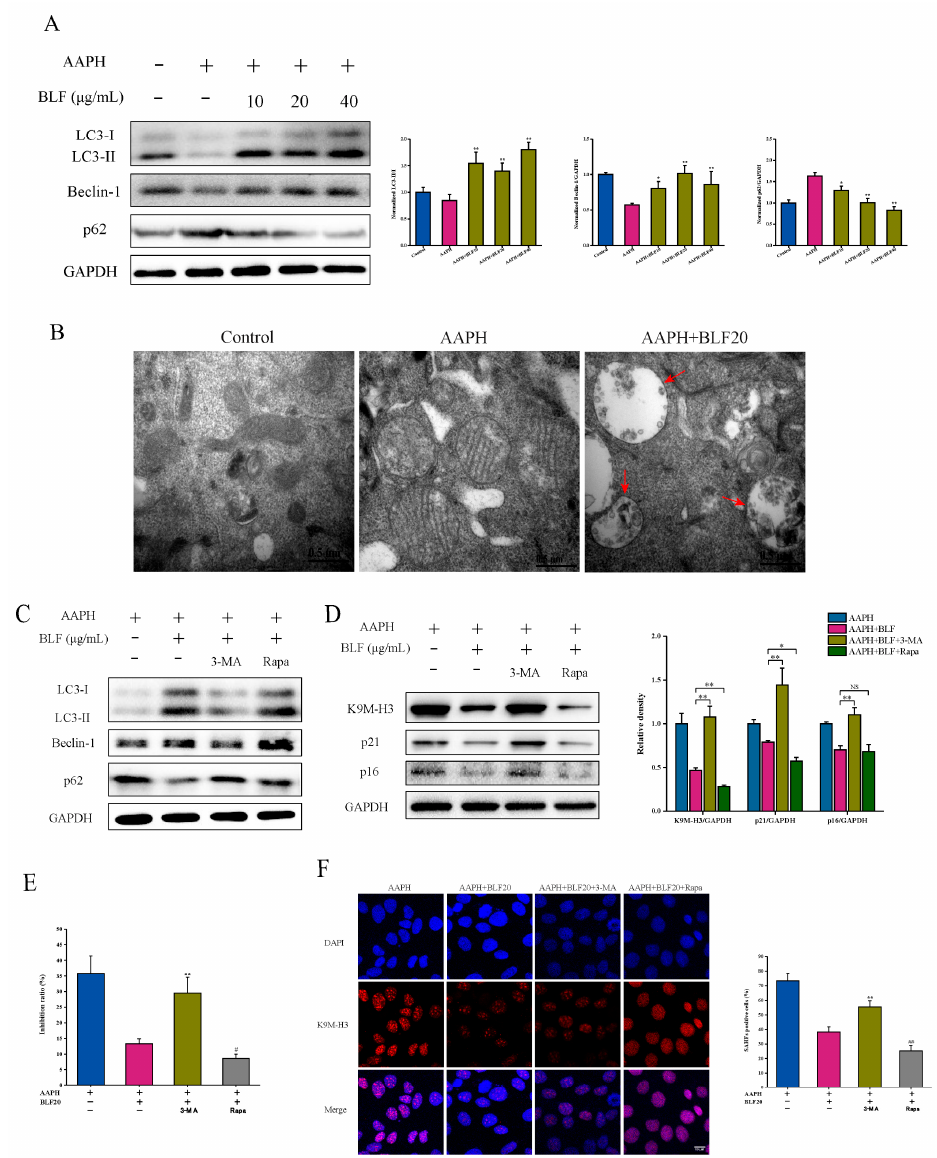
Figure 5. Autophagy participated in the anti-senescence effect of BLF. ( A ) Protein expression of LC3-I/II, Beclin-1, and p62 determined by Western blotting ( left ). Quantitation is shown on the right. * p < 0.05, ** p < 0.01 vs. AAPH+BLF group. ( B ) Autophagosomes detected by TEM. Representative images are shown. Scale bar = 0.5 µ m. ( C ) HaCaT cells were pretreated with 20 µ g/mL BLF, 100 nM Rapa, or 5 mM 3-MA for 1 h and then co-incubated with 1 mM AAPH for another 48 h. Protein expression of LC3-I/II, Beclin-1, and p62 determined by Western blotting after 3-MA and Rapa treatment in HaCaT cells. ( D ) Protein expression of p21, p16, and K9M-H3 determined by Western blotting after 3-MA and Rapa treatment in HaCaT cells ( left ). Quantitation is shown on the right. * p < 0.05, ** p < 0.01. NS, no significant difference. ( E ) The proliferation inhibition of HaCaT cells determined by the MTT assay after 3-MA and Rapa treatment in HaCaT cells, # p < 0.05, ## p < 0.01. ( F ) Representative images of SAHF formation photographed by confocal microscope after 3-MA and Rapa treatment in HaCaT cells. Scale bar = 10 µ m. The percentage of SAHF positive cells is shown in the right.